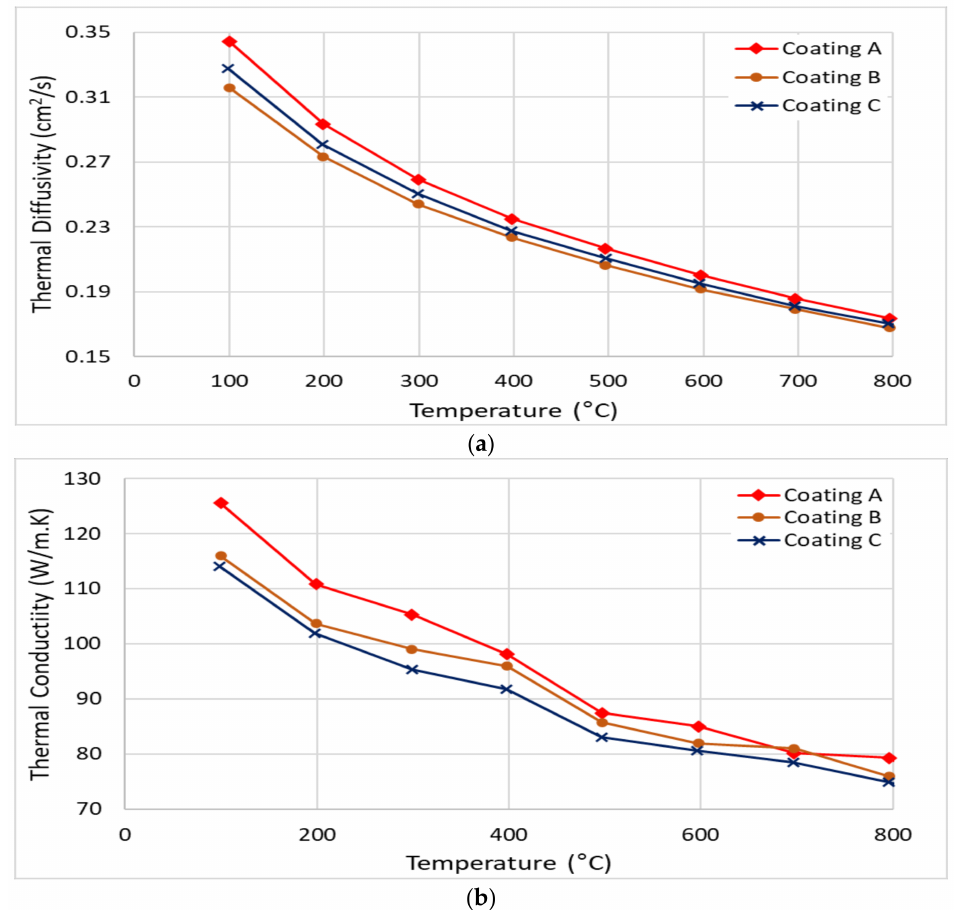
Figure 16. Temperature dependent data of ( a ) thermal diffusivity and ( b ) thermal conductivity for the three TiB 2